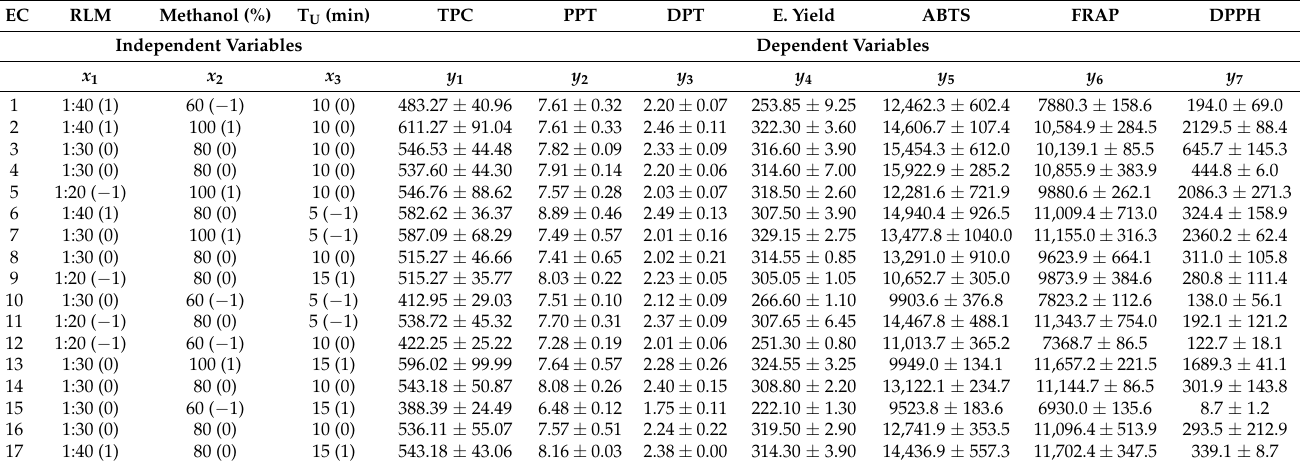
Table 2. Box–Behnken experimental design (expressed as independent variables) and experimental results obtained for dependent variables.